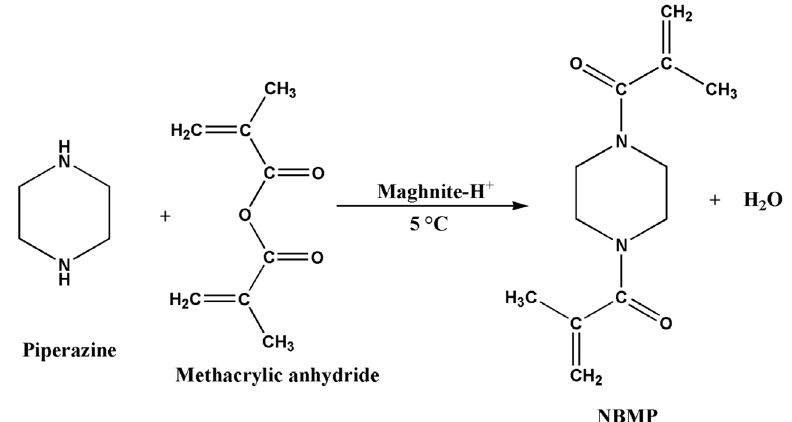
Figure 1: Representative scheme for the synthesis of NBMP catalyzed by maghnite-H +